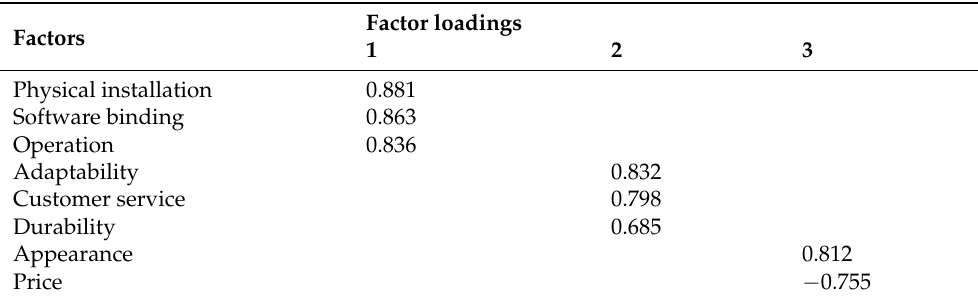
Table 4. Factor loadings of the evaluation items (varimax with Kaiser normalization); only the factor loadings >0.5 are